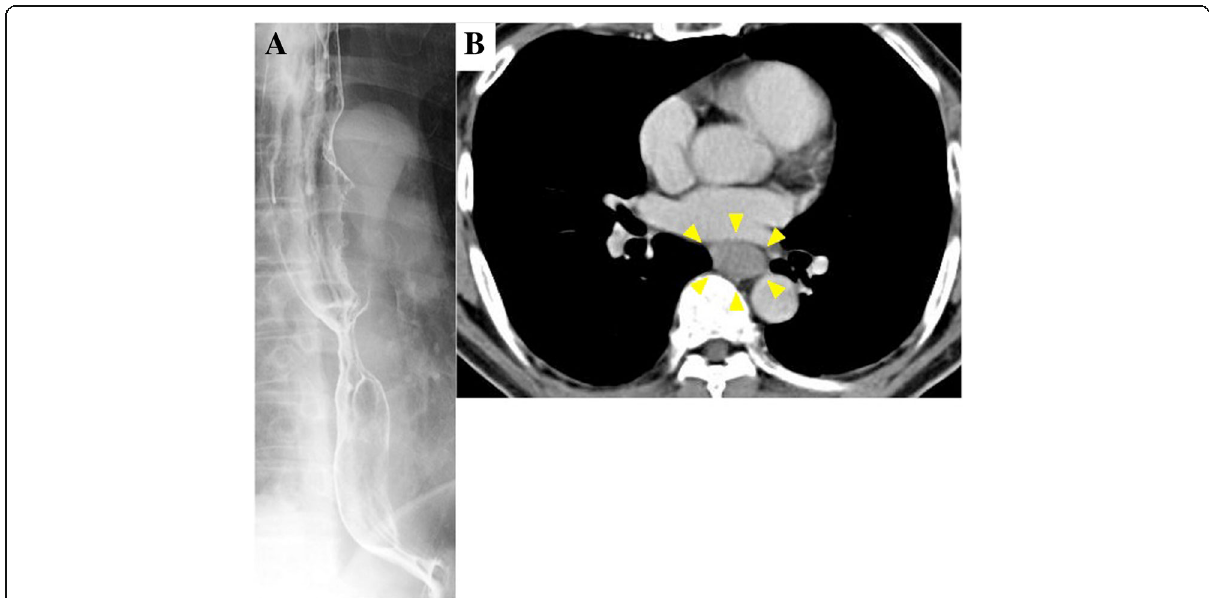
air and atelectasis of the right lower lobe. Endoscopy and